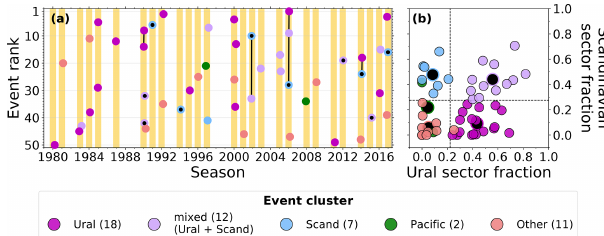
Figure 6. Classification of the top 50 warm extremes by type of blocking. (a) The 50 events ordered by time and ranked by the strength of the temperature anomaly. Events discussed in the Scan- dinavian event analysis (Sect. 5.2) are marked with a black dot. Multiple warm events associated with a single blocking event are connected by a thick black line. Yellow bars mark the NDJFM sea- son for each year (where, e.g., 1980 refers to winter − 79 to − 80). (b) Scatter plot of Ural vs. Scandinavian daily blocking index for the 50 warm events. Smaller circles mark the maximum index value in the 6d preceding each event; large circles with black center in- dicate mean values for each cluster. Dashed lines show the 90th percentile threshold for each index. The marker colors refer to the five different event clusters (see